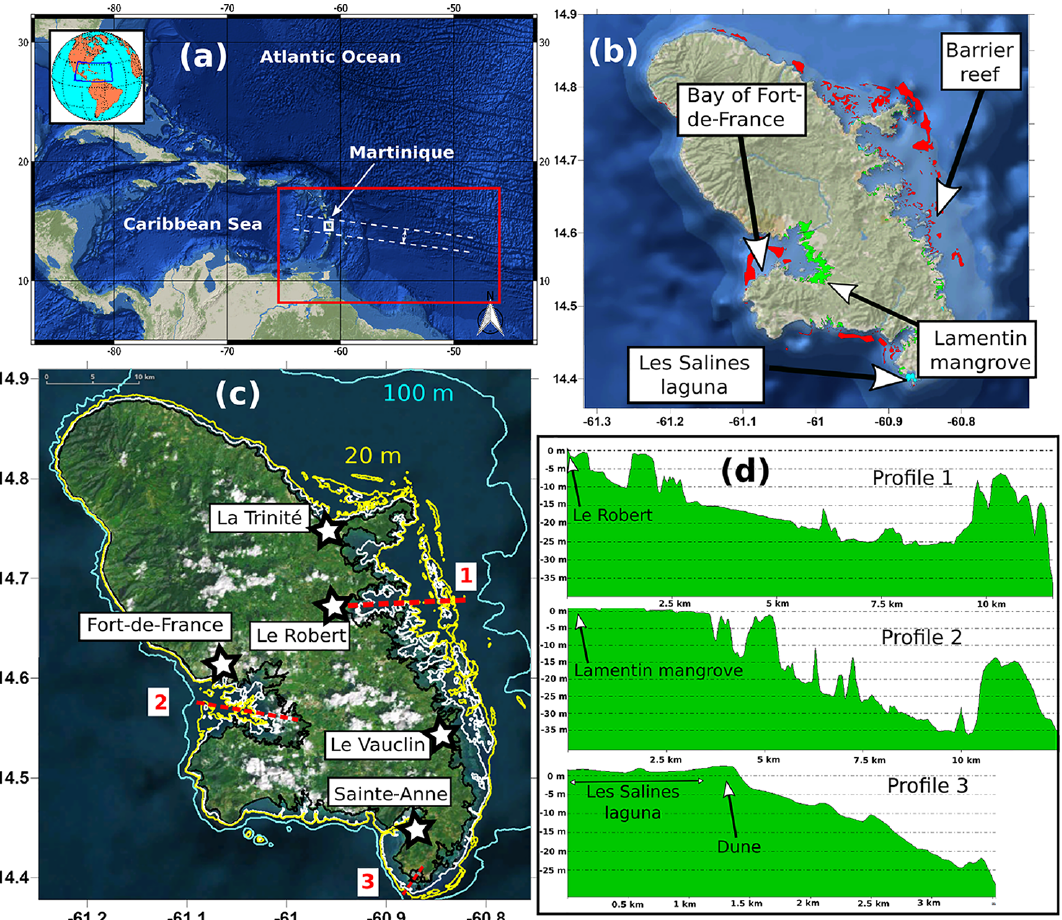
Figure 1. (a) Area of interest. The computational domain is given in red. Dashed white lines represent the southernmost and northernmost tracks considered for the “worst case scenarios” (Sect. 5.1). (b) Focus on Martinique and the location of coral reef communities (red), mangroves areas (green) and lagoons (cyan). Source of data: agence des aires marines protégées. (c) Isobaths at 10m (white), 20m (yellow), and 100m (cyan), as well as location of the bathymetric profiles displayed in (d)